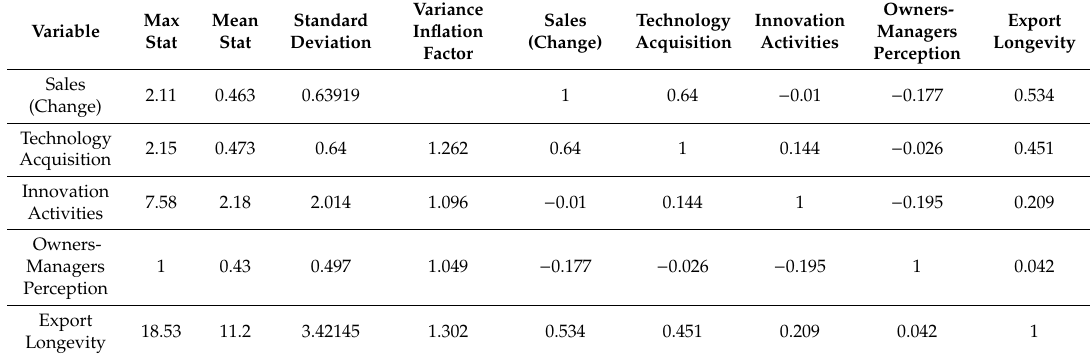
Table 2. Descriptive statistics (normalized) and correlation